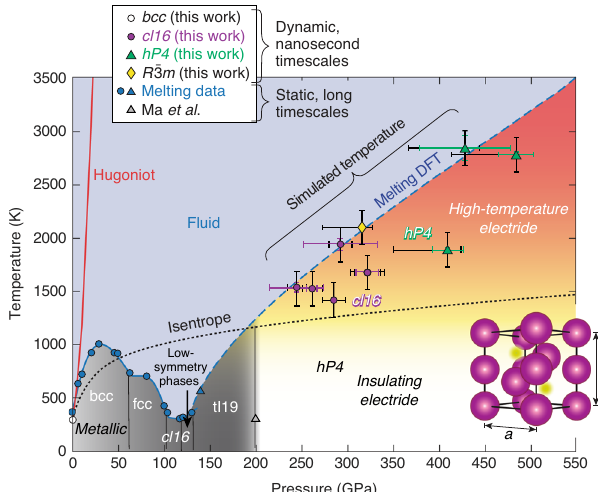
Fig. 1 High-pressure Na phase diagram. The high-pressure phase diagram of Na based on our laser-driven ramp-compression data (black error bars represent systematic and random uncertainties; color “ error ” bars represent standard deviation in pressure and temperature states within the sample) and previous work from refs. 3,4,21,22,32 . The data are compared to the theoretical principal Hugoniot and isentrope. The melting curve data from refs. 22,21 are shown along with a Kechin 33 fi t to density-functional- theory (DFT) calculations 4 for the melting curve (blue dashed line) above 130 GPa in the hP4 phase (structural model (bottom-right): Na + ions (purple), localized electrons (yellow)). Four different phases of Na, bcc, cI16 , R (cid:1) 3 m and hP4 , are observed. The temperatures are estimated from hydrodynamics simulations (see Supplementary Discussion). The present re fl ectivity and X-ray diffraction data along with computations suggest a high-temperature electride region (shaded